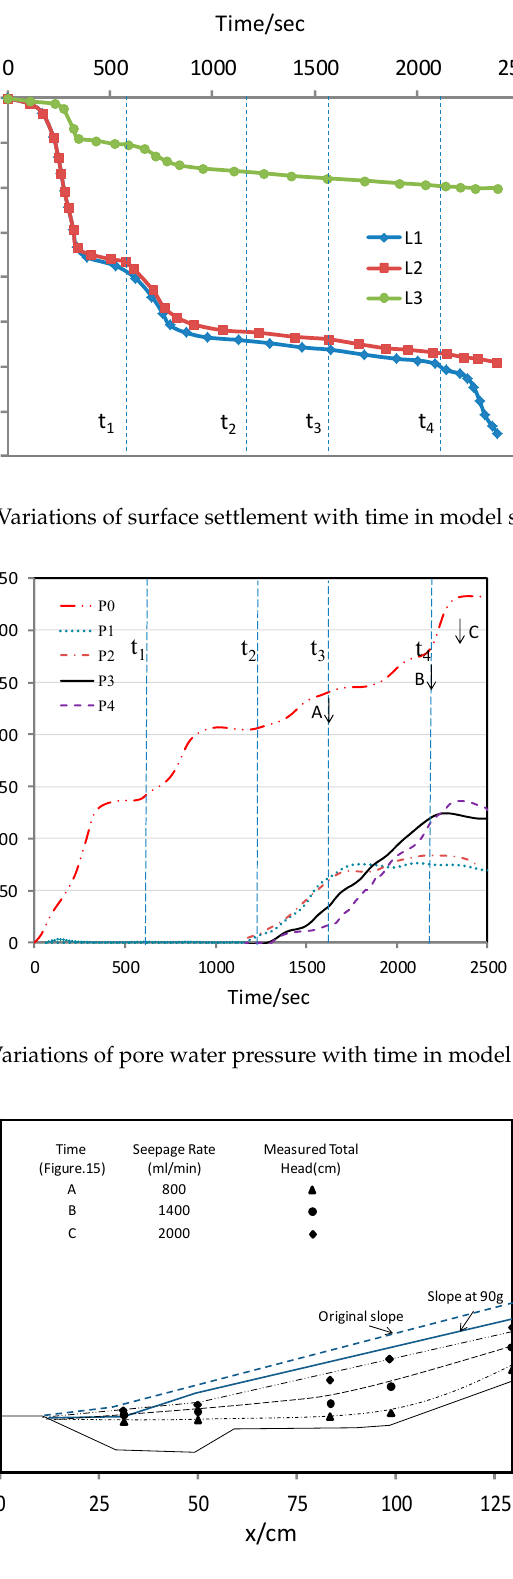
Figure 16. Variations of ground water level in model slope.